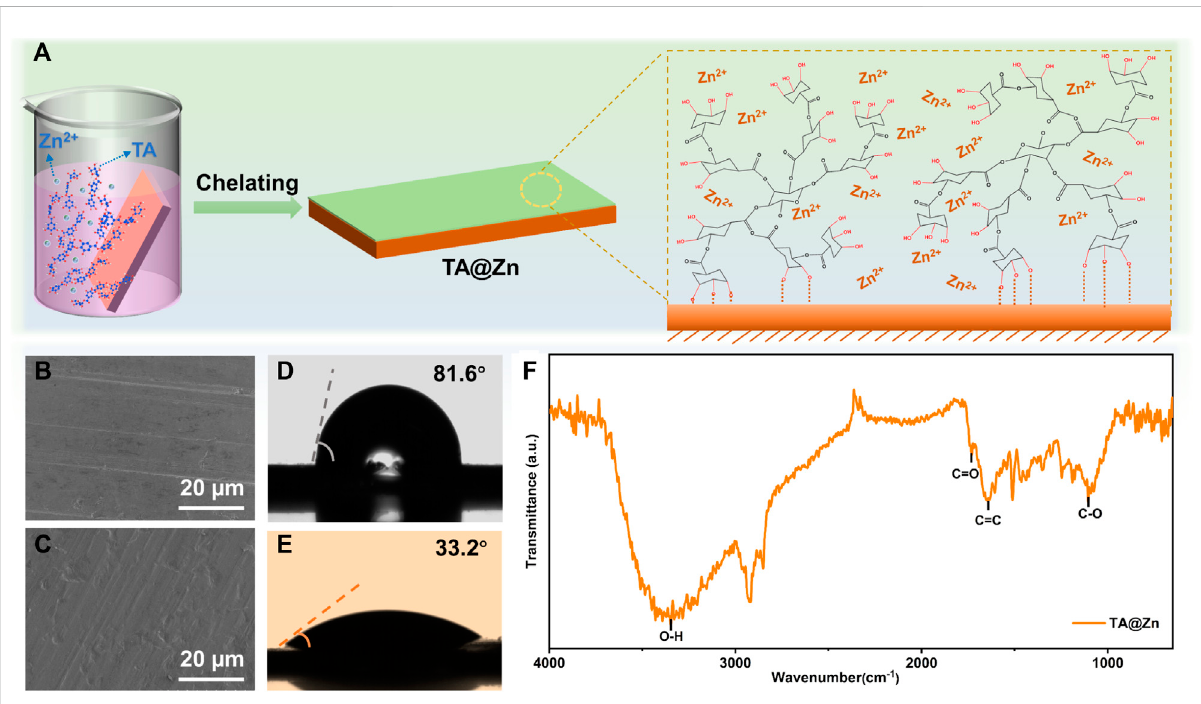
FIGURE 1 FabricationandcharacterizationofTA@Zn. (A) schematicillustrationofthepreparationprocessofTA@Zn.Scanningelectronmicroscopy(SEM) images of (B) bare Zn and (C) TA@Zn after 50 cycles (100 h) at 1 mA cm − 2 with an areal capacity of 1 mAh cm − 2 . Contact angle measurement of (D) bare Zn and (E) TA@Zn with 2 M ZnSO 4 electrolyte. (F) ATR-FTIR spectrum of